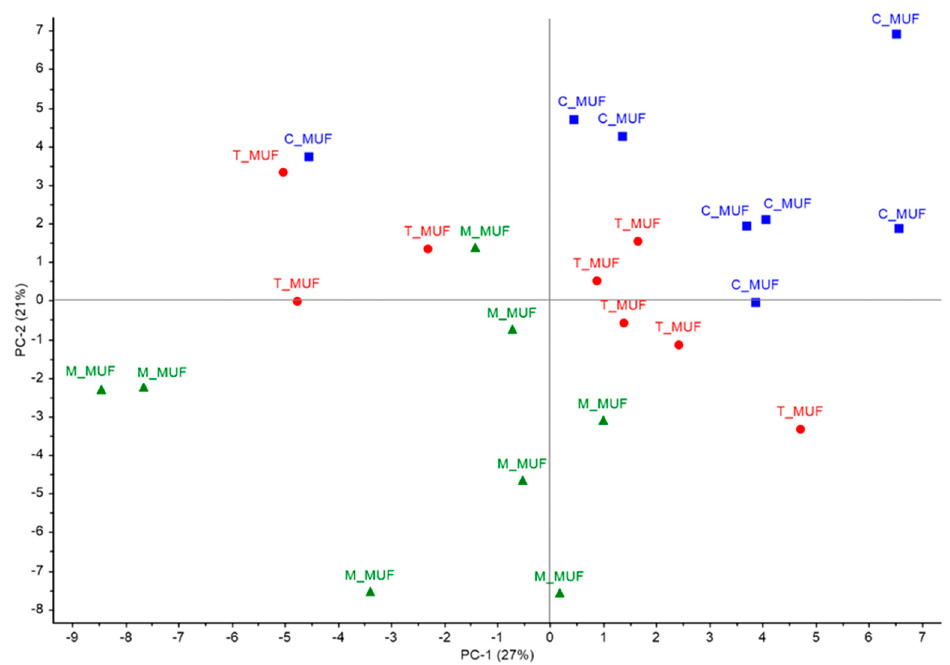
Figure 10. PCA Score plot of sensory evaluation of C_MUF, M_MUF and T_MUF muffin samples.